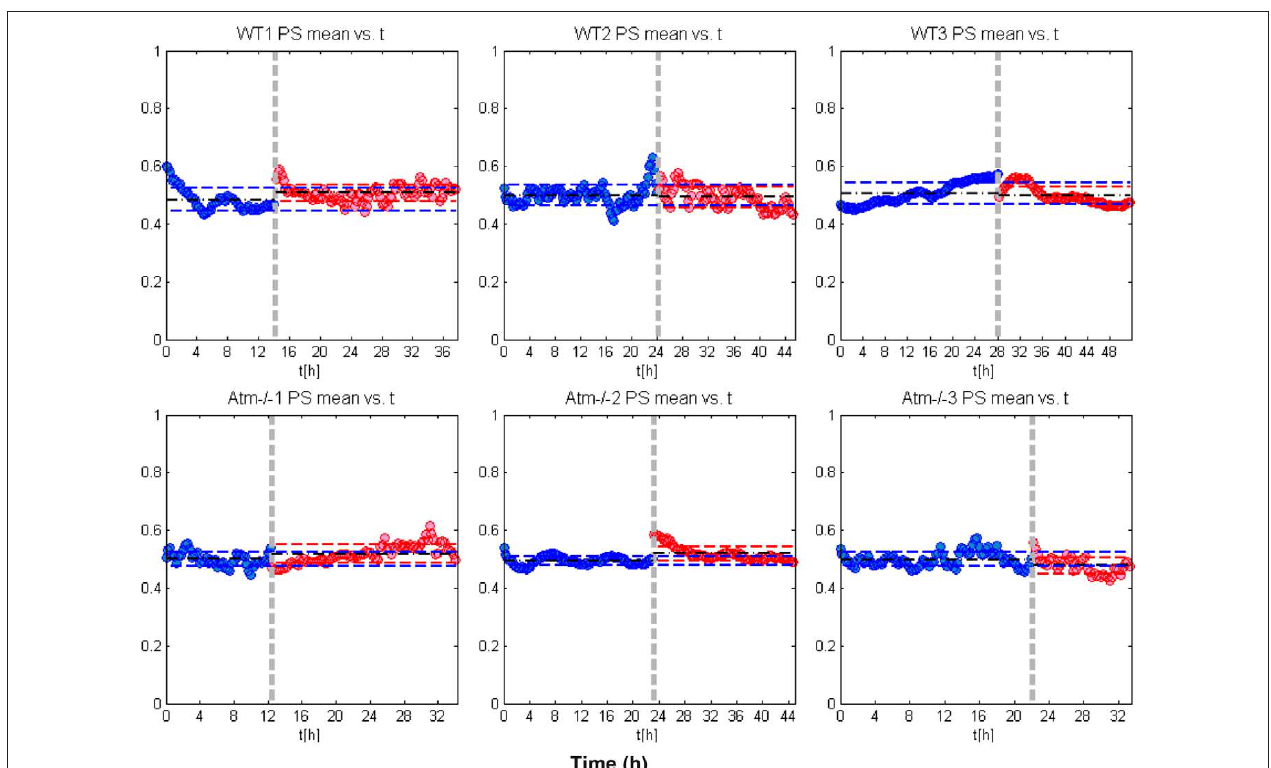
Figure 6 | global (mean) network synchronization. In this figure we show the global network phase synchronization (PS) as function of time. Each dot (blue or red), corresponds to the global synchronization calculated for a time window of 15 min. As is explained in the article, the global PS is simply the sum of the PS between every pairs of neurons. To ease the comparison we actually calculated Atm − / − networks even after the NCS imposed DNA damage (red dots).